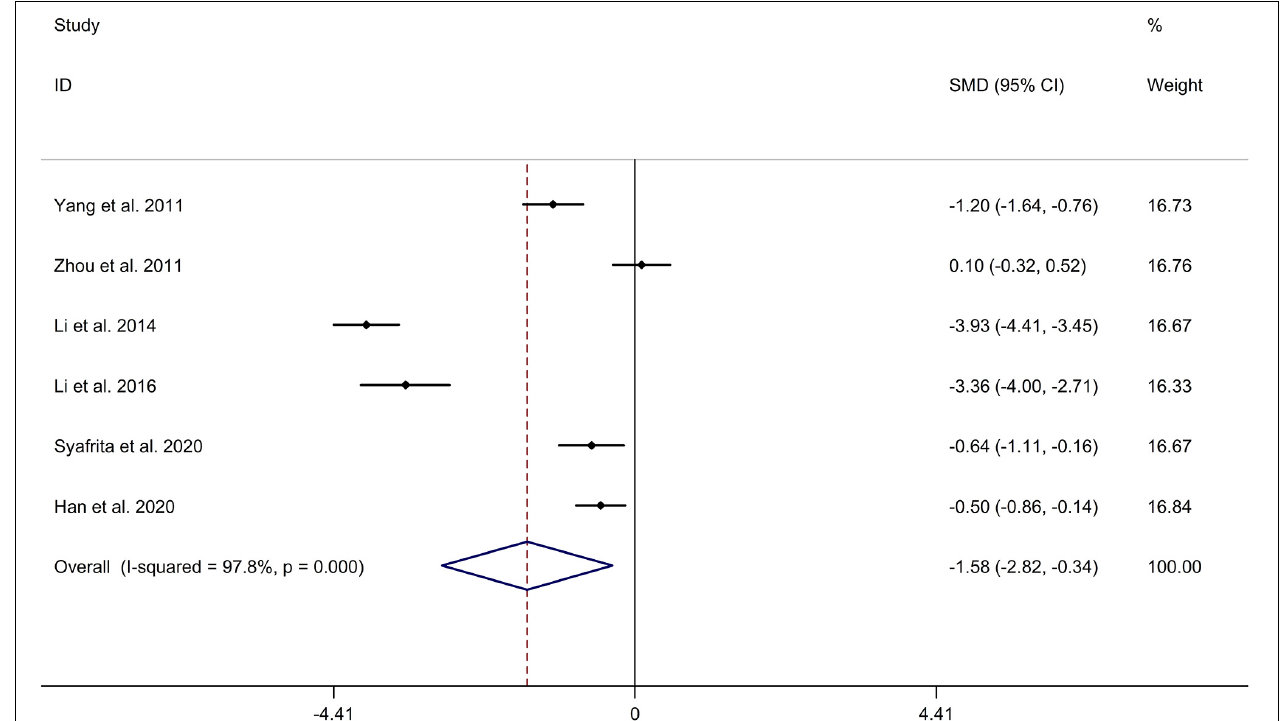
FIGURE 2 | Forest plots of comparison of serum BDNF level between patients with PSD and stroke patients without PSD. BDNF, brain-derived neurotrophic factor; PSD, poststroke depression.